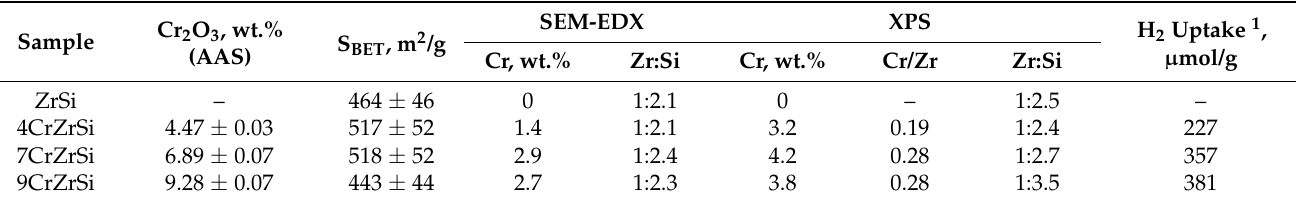
Table 1. Physicochemical parameters of fresh